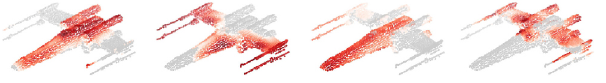
Fig. 4 Normalized attention weights of some representative channels in the SFM.